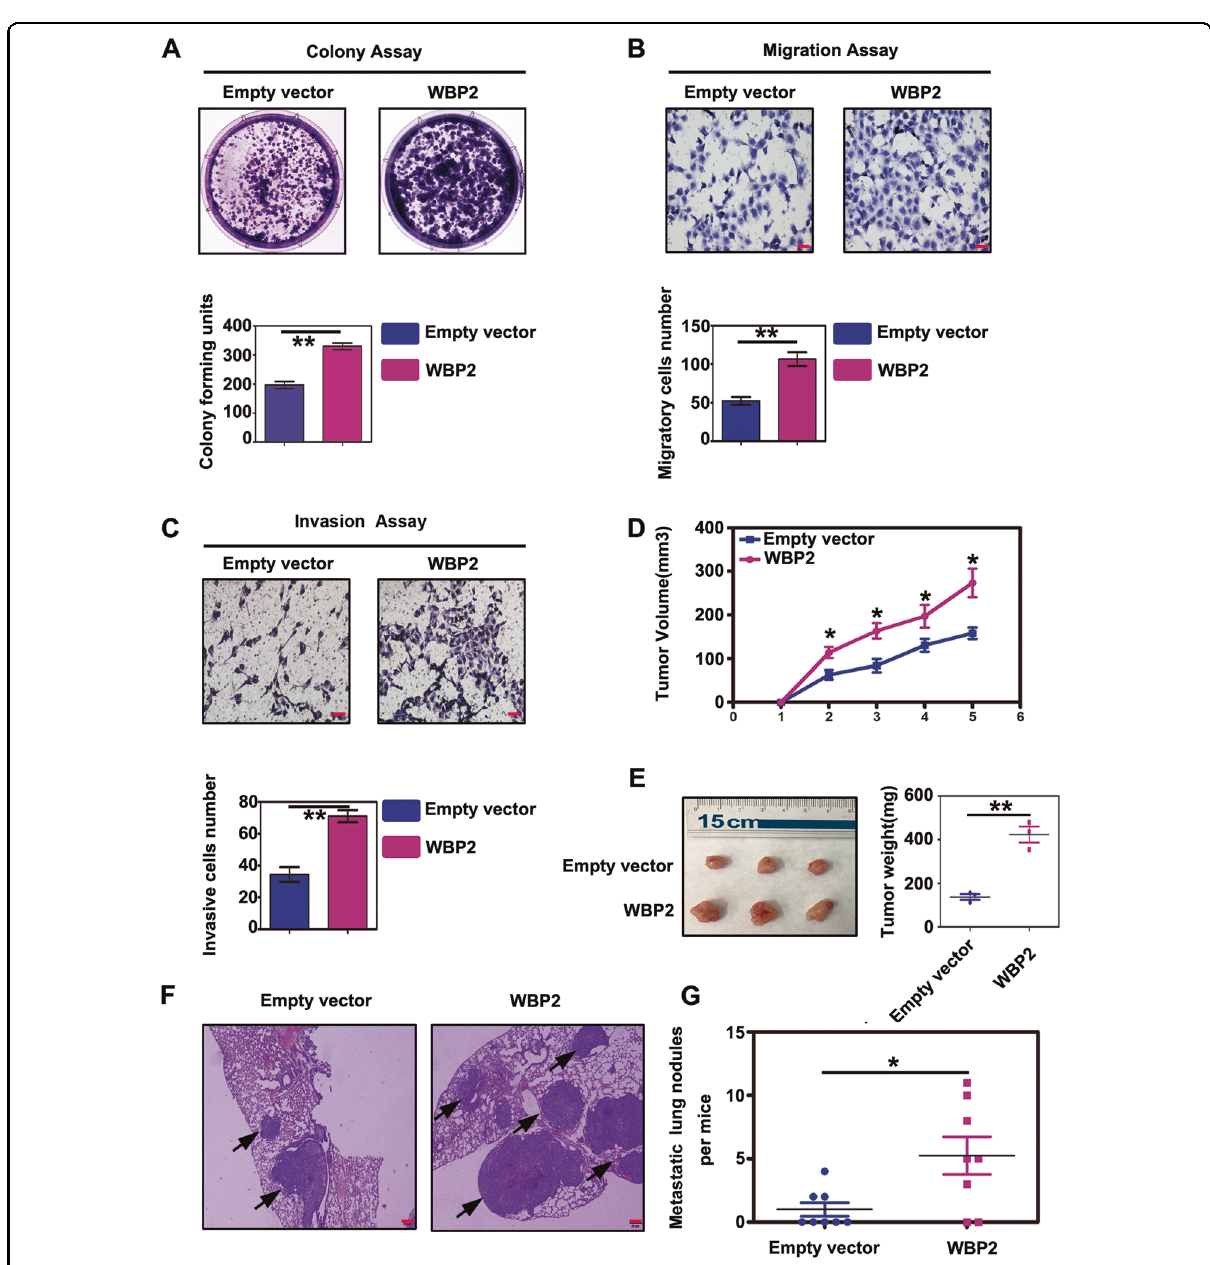
Fig. 2 Overexpression of WBP2 promotes proliferation, invasion, and metastasis of lung cancer cells. A – C , In vivo experiments: the plasmid WBP2 was transfected into the H1299 cell line, and stable expression monoclonal cells were screened using G418 (800 μ g/mL). Colony-forming assays and transwell assays revealed that overexpression of WBP2 protein signi fi cantly enhances the proliferation ( A control vs WBP2: 196 ± 12 vs. 330 ± 12, P < 0.01), migration ( B control vs. WBP2: 52 ± 5 vs. 106 ± 8, P < 0.01), and invasiveness ( C control vs. WBP2: 34 ± 4 vs. 71 ± 3, P < 0.01) of lung cancer cells. D – G Subcutaneous tumor transplantation and lung metastasis experiments via tail vein injections in nude mice demonstrate that the volumes and weights of subcutaneous transplanted tumors in nude mice are both signi fi cantly increased following WBP2 overexpression ( D , E Volume:control vs WBP2: 157.7 ± 13.0 vs 273.3 ± 32.8 [mm 3 ], P < 0.05; weight:control vs WBP2: 137.3 ± 13.1 vs 423.3 ± 36.5 [mg], P < 0.01). The number of lung cancer metastasis foci is also markedly increased ( F , G control vs WBP2: 1.0 ± 0.5 vs 5.2 ± 1.5, P < 0.05). P < 0.05 indicates statistical signi fi cance, * P < 0.05, ** P <